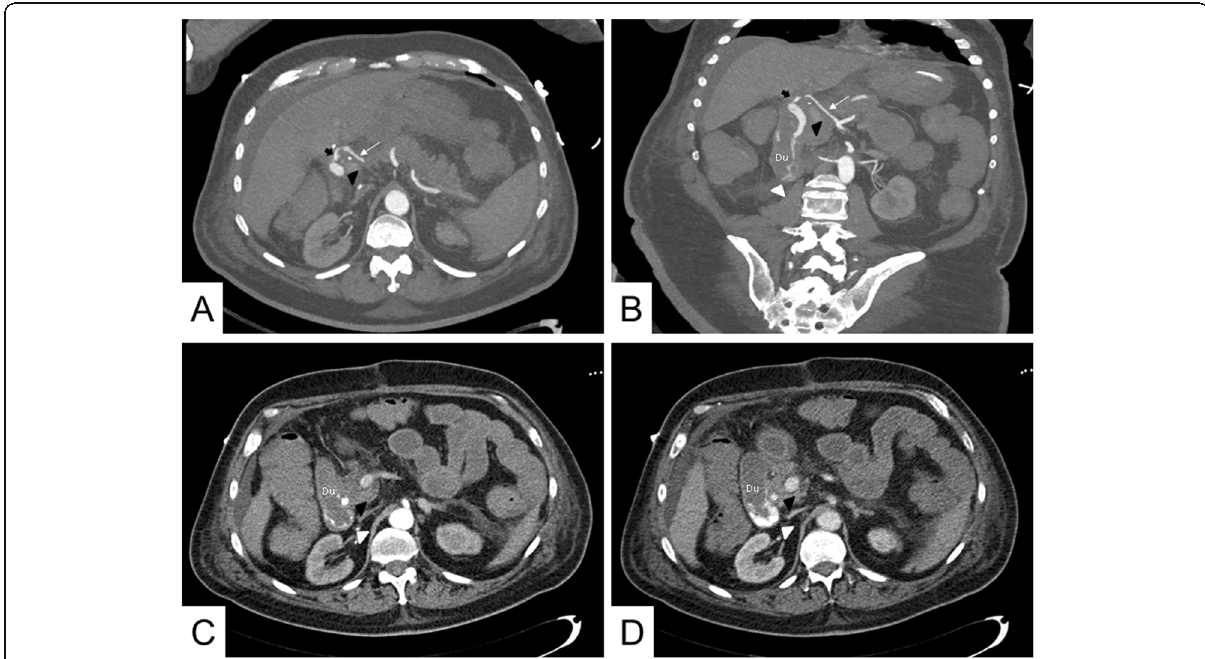
Fig. 1 Contrast-enhanced CT showing a HAP with an ABF, hemobilia, and upper GI bleeding. a-b Axial and coronal sections processed with a maximum intensity projection (MIP) of a contrast-enhanced CT, showing a pseudoaneurysm (thick black arrow) from the liver graft hepatic artery (thin white arrow). Immediately adjacent is the bile duct filled with iodinated contrast (black triangle), indicating the presence of an ABF with hemobilia. c-d Axial section of a contrast-enhanced CT showing contrast extravasation into the duodenum (Du), which increases in quantity between the arterial phase ( c ) and the venous phase ( d ), consistent with an upper GI bleeding (white head